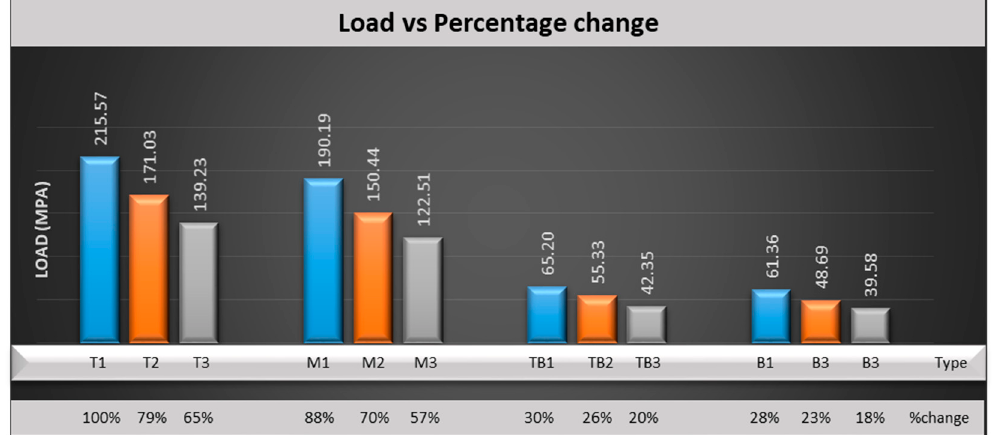
Figure 19. Analysis of % load.